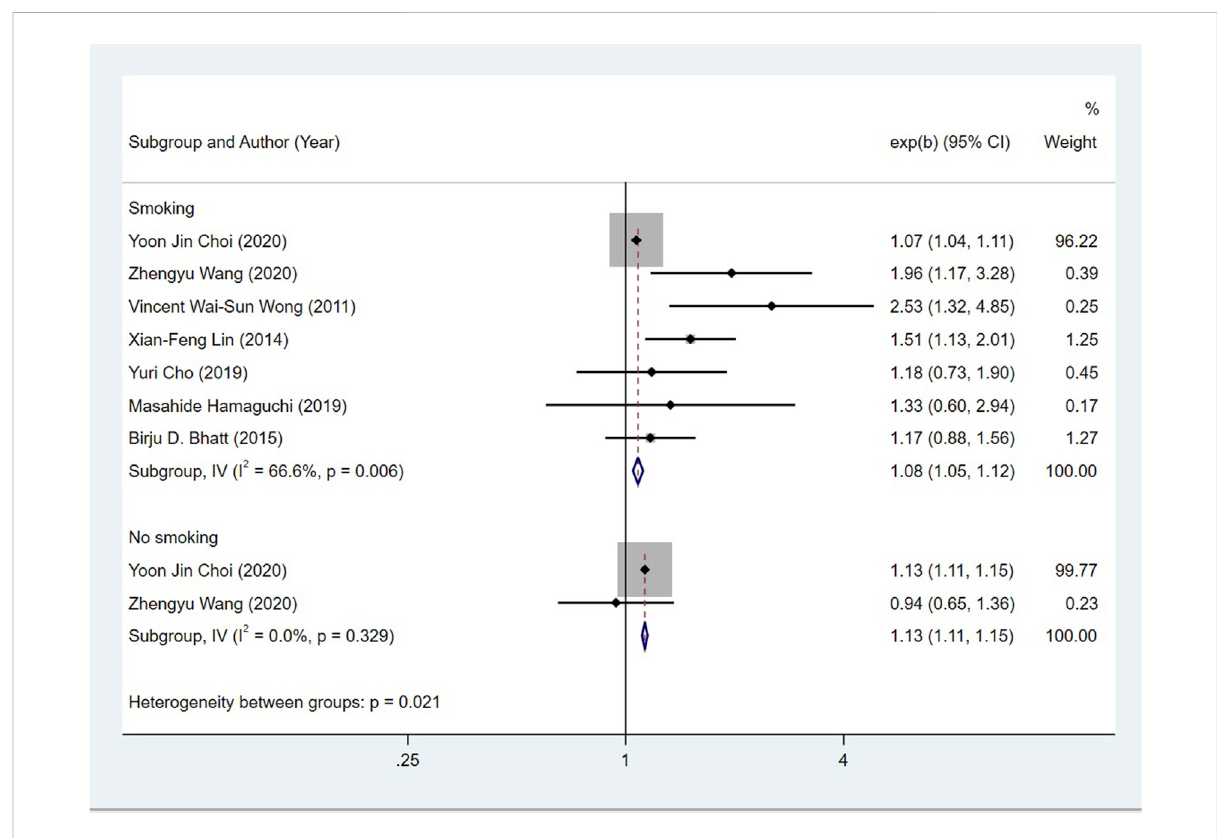
Subgroup analysis for the risk of CRC in patients with NAFLD in different smoking